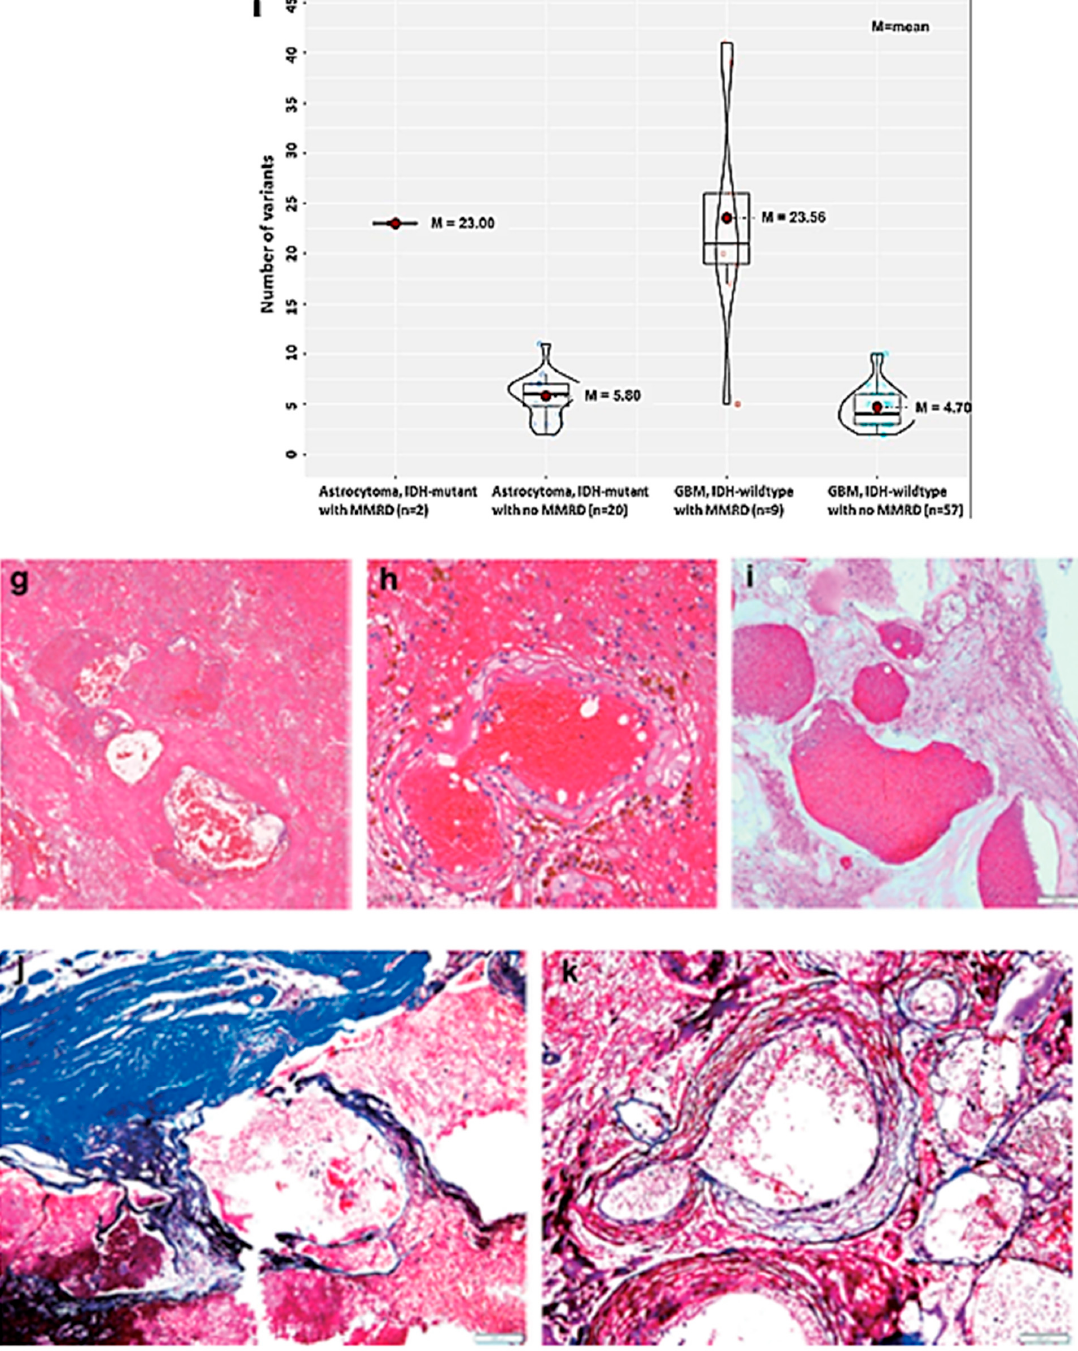
Figure 3. Advances in non-imaging diagnosis of HGG. ( a ). Column chart demonstrating signi fi cantly over-expressed genes in the plasma samples of glioma patients relative to those of healthy control. ( b ). Column chart demonstrating signi fi cantly under-expressed genes in the plasma samples of glioma patients relative to those of healthy control (reproduced from [36] with permission). ( c – e ). Brain activity of peritumoral and homologue contralateral areas. Peritumoral brain activity level was signi fi cantly higher compared to the level in the homologue contralateral areas. p < 0.001 after correction for three comparisons ( c: broadband power; d: o ff set; e: slope). A.U. = arbitrary units (reproduced from [37] with permission). ( f ). The box plot of the number of nonsense mutation of HGG with/without mismatch repair deficiency (MMRD). MMRD HGG had a higher number of